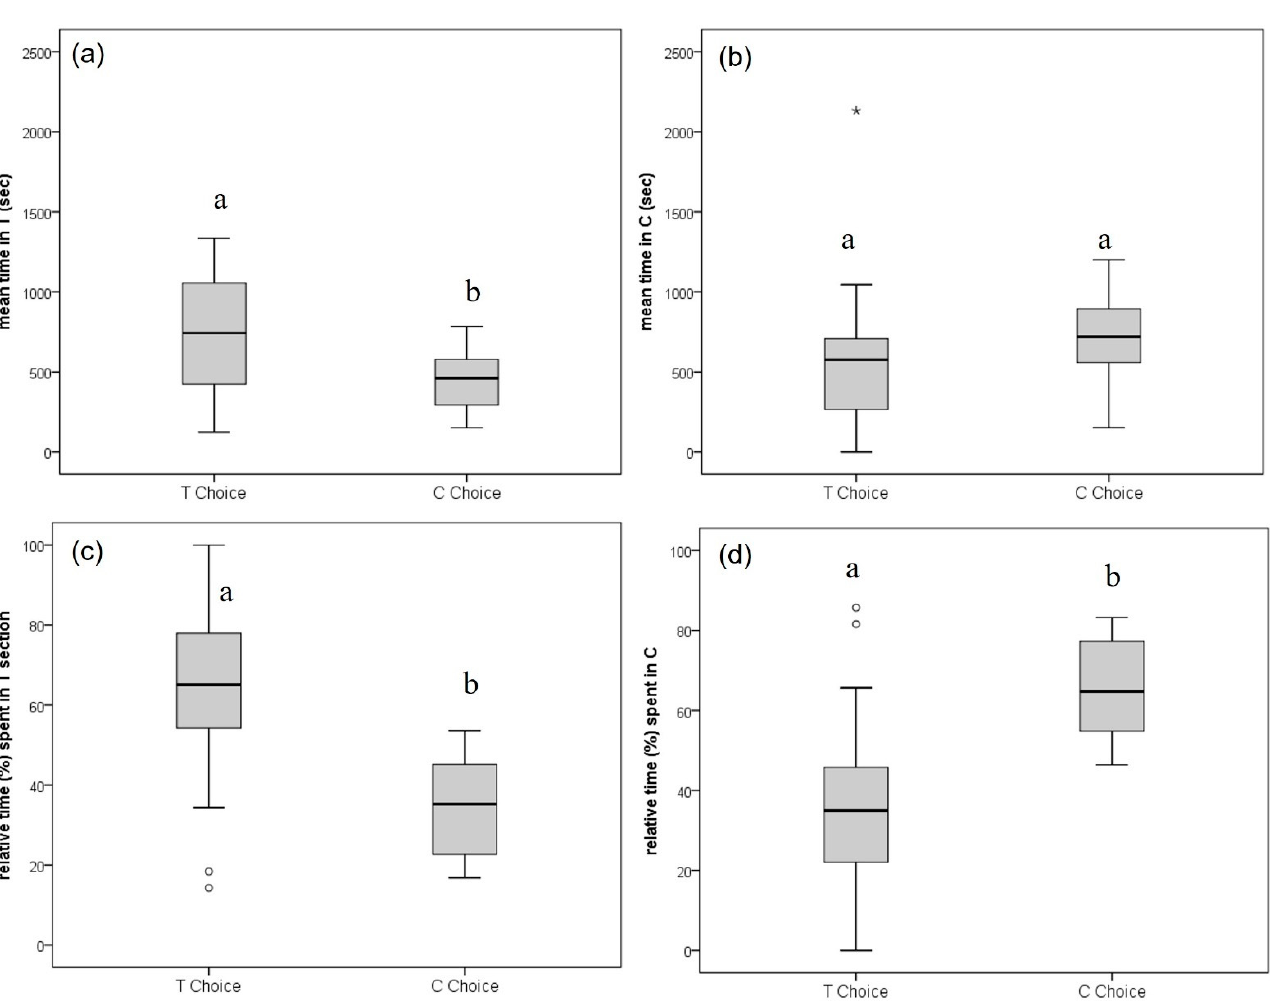
Figure 4. Differences between test runs ending with a T and C choice in mean duration of stay (mean time in seconds) in ( a ) section T and ( b ) section C; in mean proportion of time (relative time in %) spent in ( c ) section T and ( d ) section C; significant differences between groups ( p ≤ 0.001) are indicated by different lower-case letters, outliers are indicated by asterisk and circles.